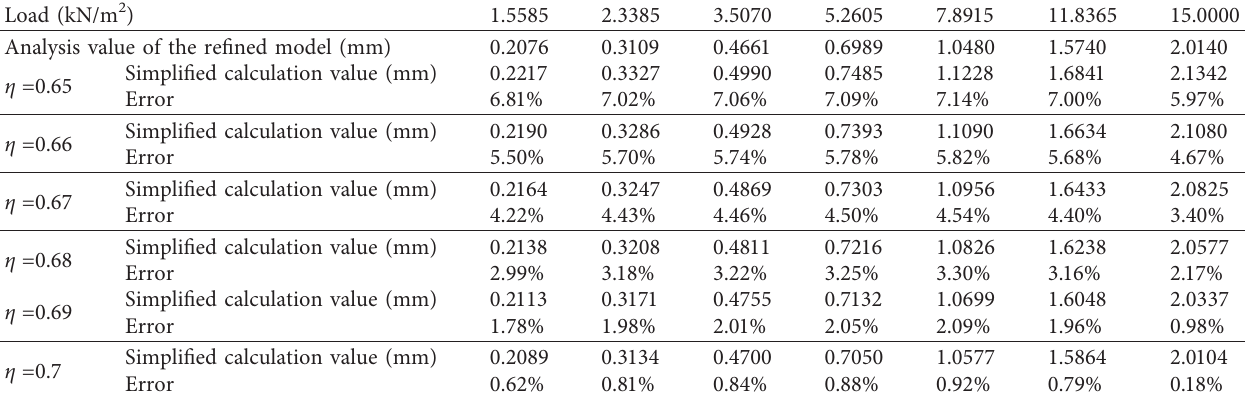
Table 8: Comparison of the deflection of different stiffness reduction factors for the single-span simply supported formwork. Load (kN/m 2 )